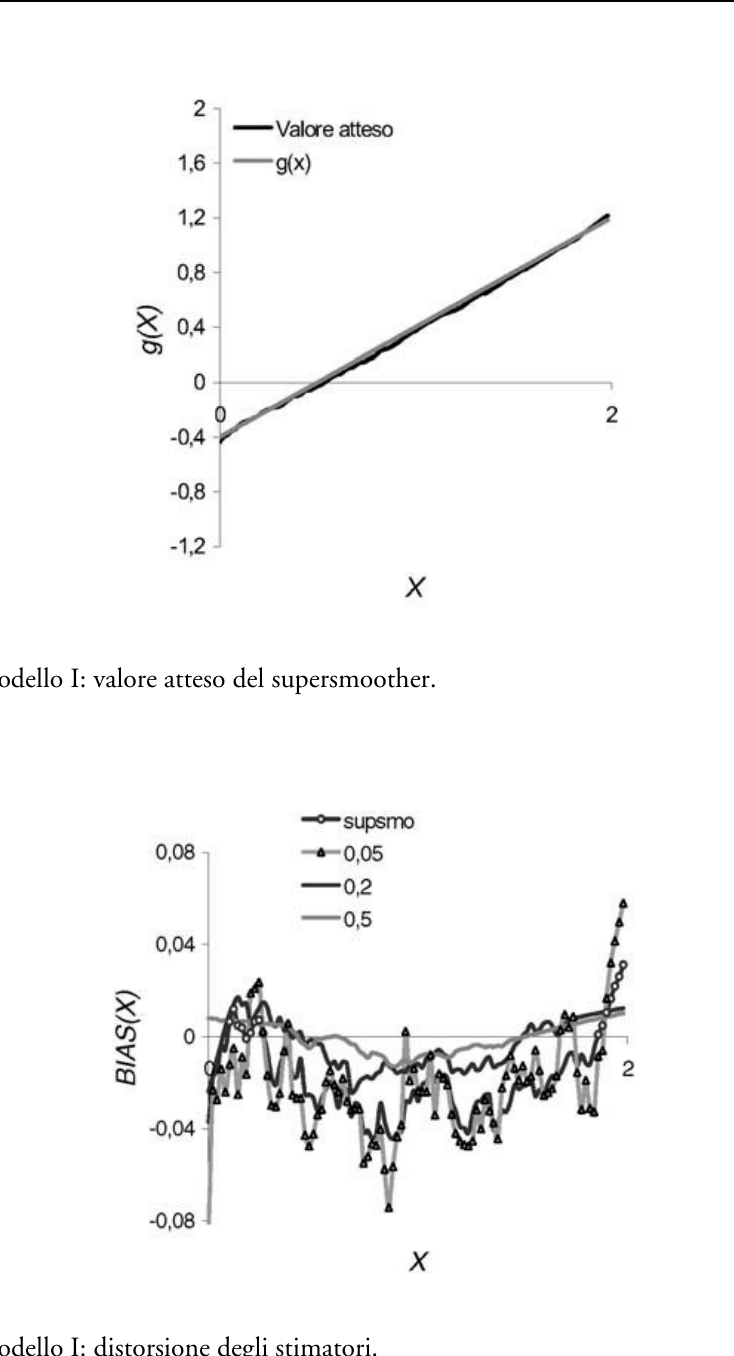
Figura 2 – Modello I: distorsione degli